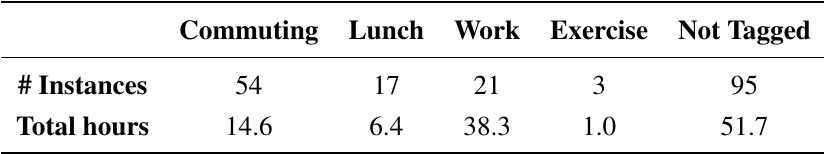
Table 3. Number of instances and duration of each self-reported activity (subject